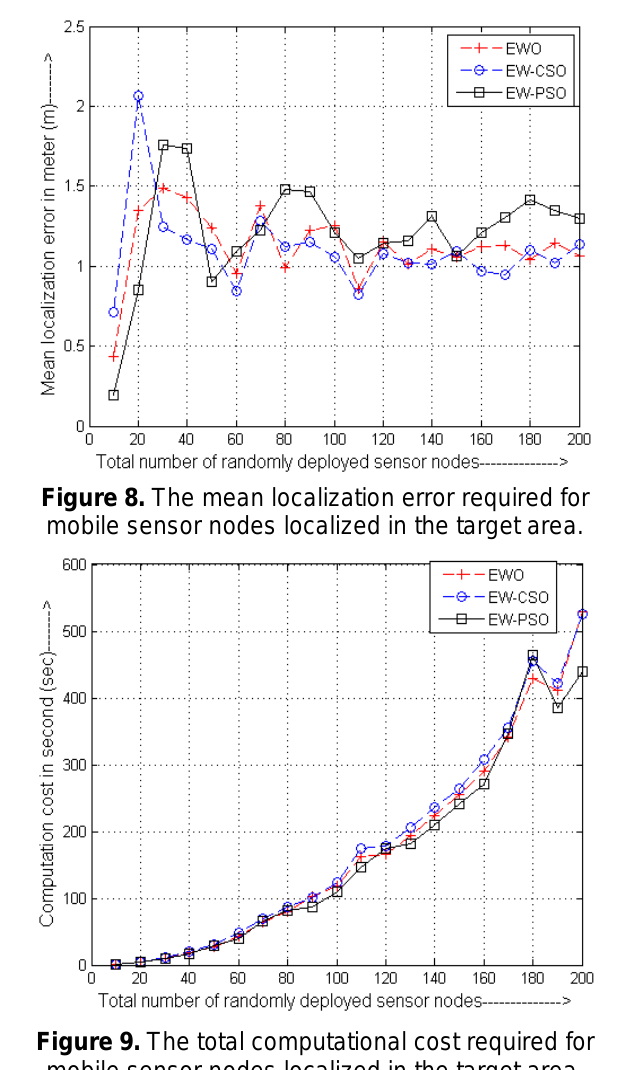
Figure 9. The total computational cost required for mobile sensor nodes localized in the target area.